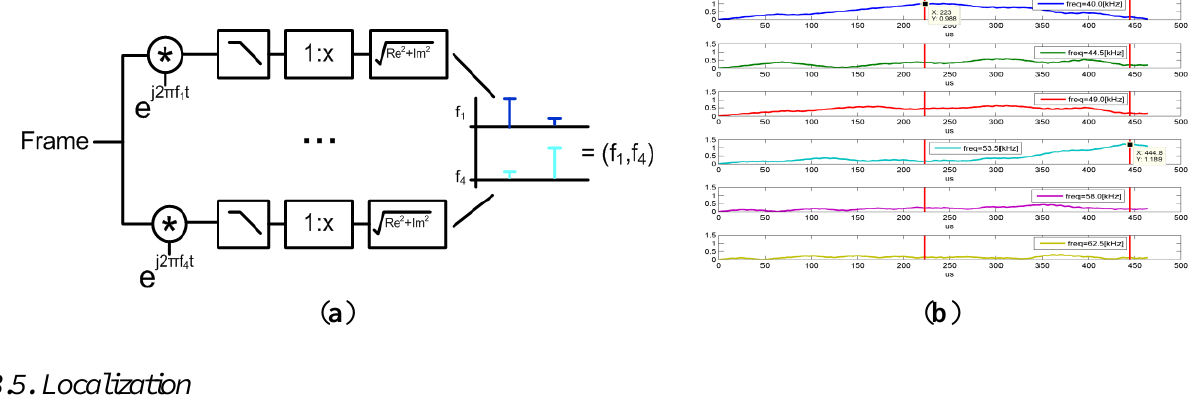
Figure 6. ( a ) Transmitter identification for n coding frequencies. Filter output values are only evaluated at discrete times as the starting time of the frame is known. ( b ) Example transmitter decoding on binary input data using . Identified transmitter is (40 kHz, 53.5 kHz). Red vertical lines mark sampling